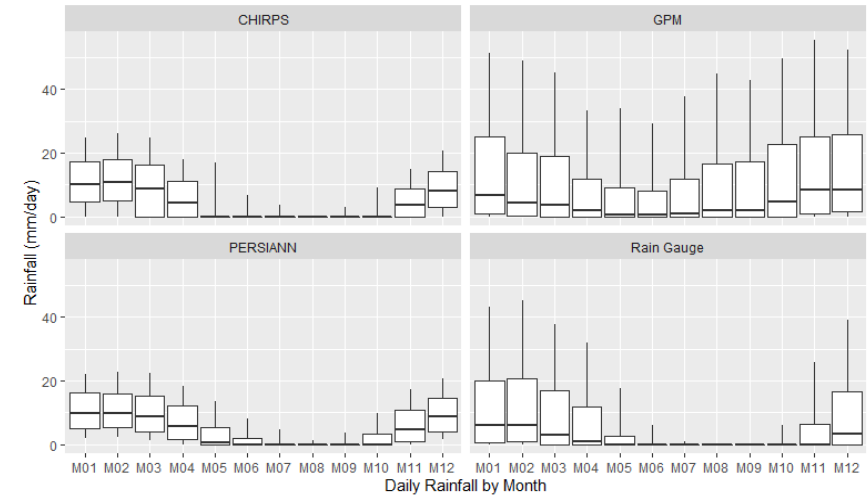
Figure 4. Variability of daily rainfall based on dry and wet season. ( A ) Outliers (>1.5 IQR were retained, ( B ) Outliers were removed for clarity (outliers represent 1.5% of the total observations).